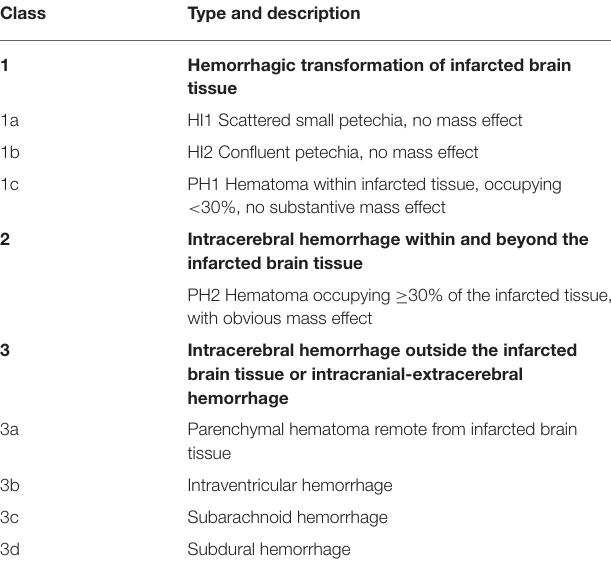
TABLE 2 | Anatomic descriptions of intracranial hemorrhages according to the heidelberg bleeding classification (28).